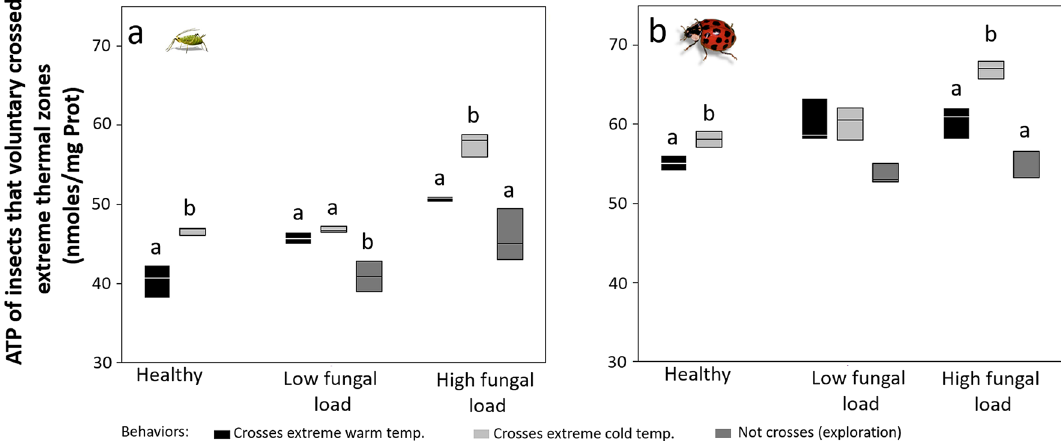
Figure 4. ATP levels of healthy and infected aphids ( a ) and predator beetles ( b ) that voluntarily crossed (or not) through extreme thermal zones (ETZ cold or warm). A. pisum F = 29.13 DF = 7,16, P < 0.001 . H. convergens : F = 16.77, DF = 7,16; P < 0.0001 Infections: Low fungal load = 1.4 × 10 6 spores ha -1 , high fungal load = 1.4 × 10 12 spores ha -1 . Box plots display median line, interquartile range (IQR) boxes, 1.5 × IQR ( n = 3 individuals per treatment). Significant difference was determined by Two-way ANOVA, followed by t-test for control treatment and multiple comparisons ( α = 0.05) within low and high fungal load treatments. Letters represent differences within treatments. Black boxes: VT Max ; dark gray boxes: no crosses (exploration); light gray: VT Min